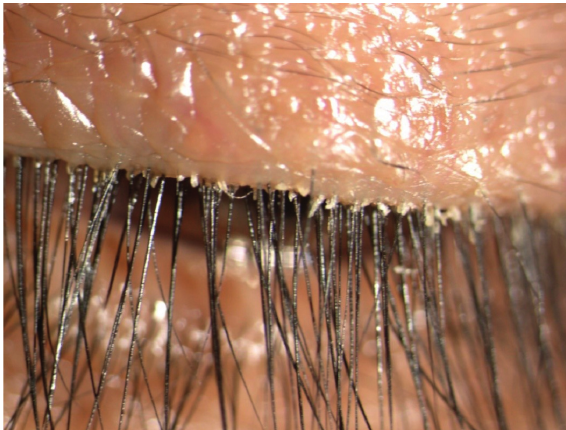
Figure 2: A magnified image of the upper lid margin in a representative eye (left eye of patient 009) shows a corrugated lid margin with significant collarettes.